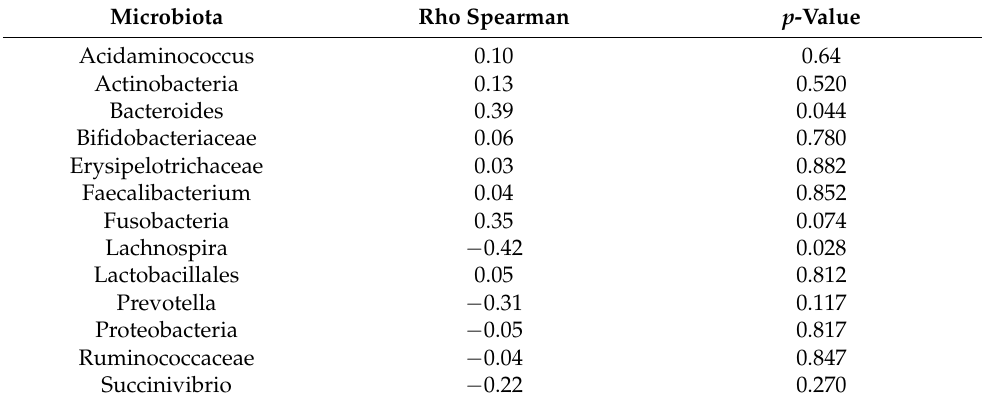
Table A5. MED-DQI correlations vs. gut microbiota.